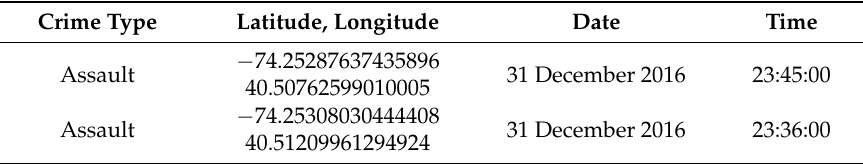
Table 2. Dataset about crimes, after the dimensionality reduction (extract).